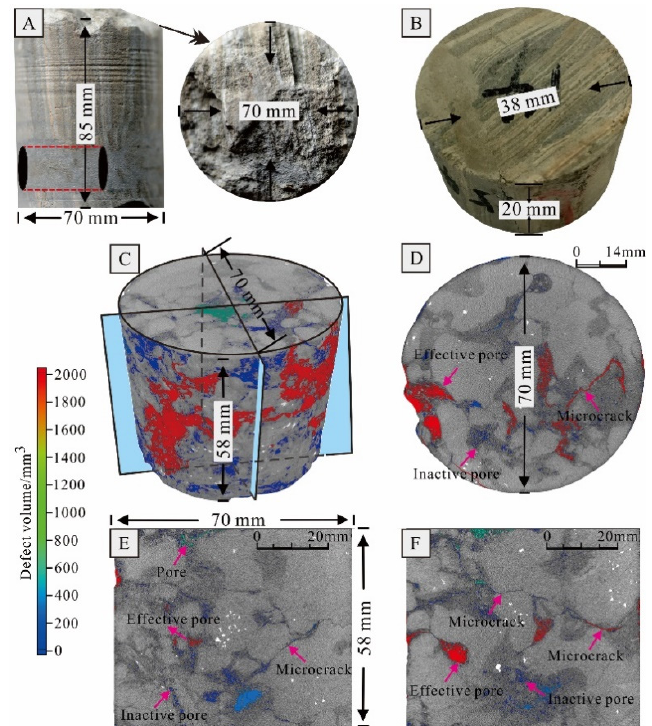
Figure 3. The core and micro-nano-computed tomography scan images of showing the characteristics of pores and fractures of the selected mixed siliciclastic-carbonate rocks. ( A ) Primitive rock samples; ( B ) Acidified rock sample; ( C ) CT scanning three-dimensional image; ( D ) Top slice of core; ( E ) Right slice of core; ( F ) Front slice of core.